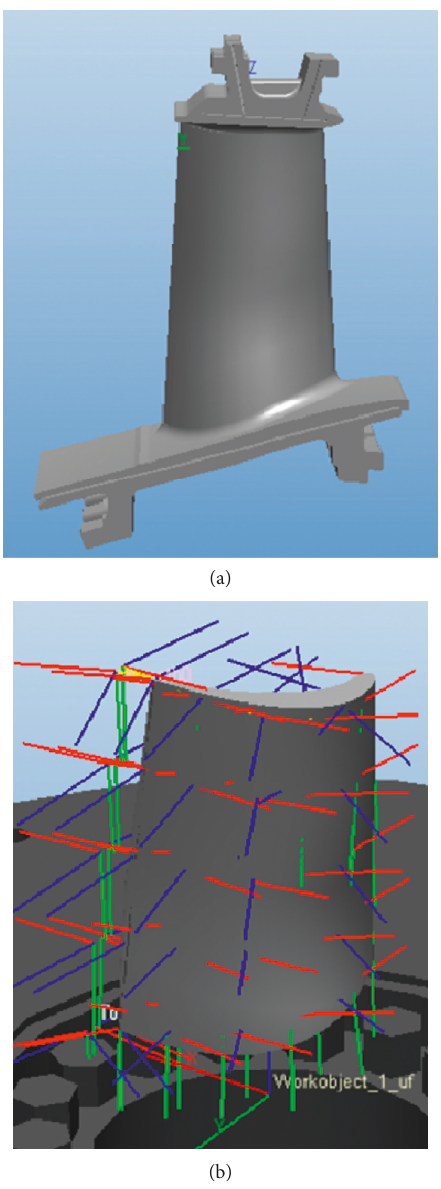
Figure 2: Complex curved surface